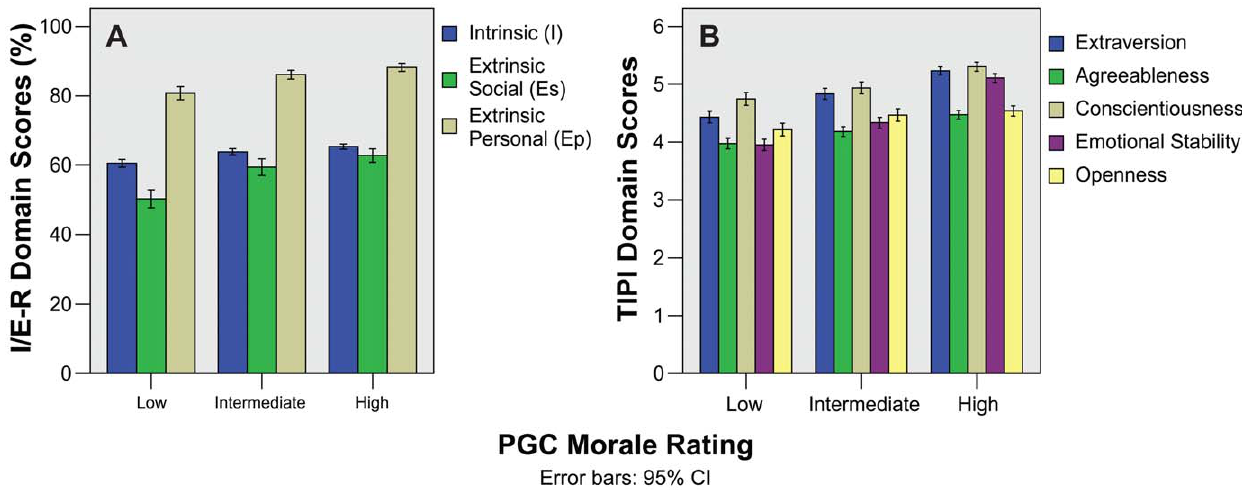
Figure 4. Bar charts showing Religiosity and Personality domain scores against PGC morale rating. A) I/E-R Religiosity, and B) TIPI Personality mean domain scores.